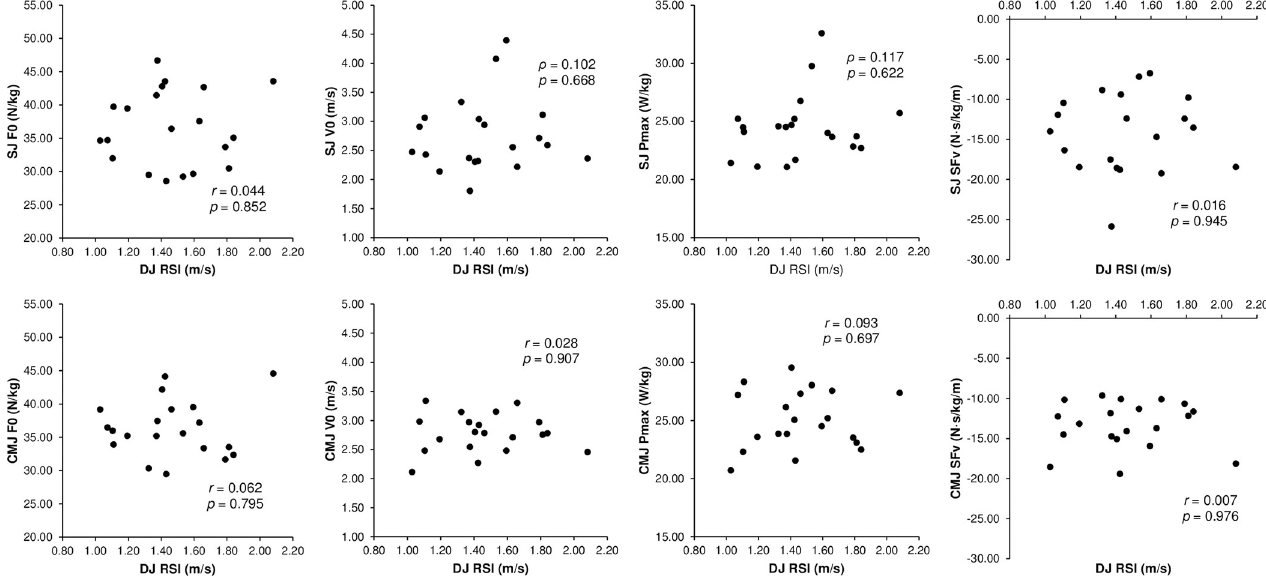
Fig 2. Associations (line-of-best-fit ± 95% confidence intervals) of the reactive strength (drop jump [DJ] reactive strength index [RSI]) with the parameters of the force–velocity (F–v) profiles obtained from the squat jump (SJ) and countermovement jump (CMJ). F0 = theoretical maximum force; V0 = theoretical maximum velocity; Pmax = theoretical maximum power; SFv = slope of the linear F–v relationship.